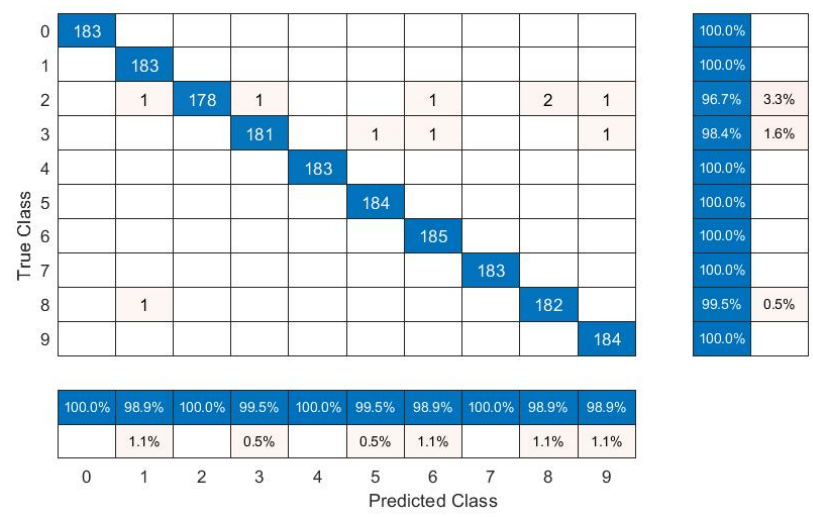
Figure 11. Confusion chart for ResNet18 (smallest training dataset).